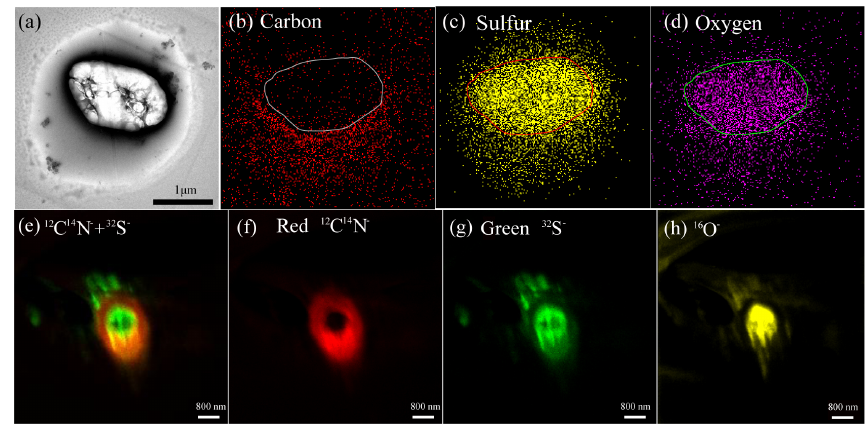
Figure 4. TEM images of a secondary particle and NanoSIMS intensity threshold maps of an aerosol particle with sulfate core and OM coating: (a) bright-field TEM image of an internally mixed particle, (b) elemental carbon, (c) sulfur and (d) oxygen maps of the internally mixed particle, (e) overlay of 12 C 14 N − and 32 S − ion maps in an internally mixed particle, (f) CN − map, (g) S − , (h) O − ion maps. Ion maps with a set of aerosol particles were shown in Fig. S1.